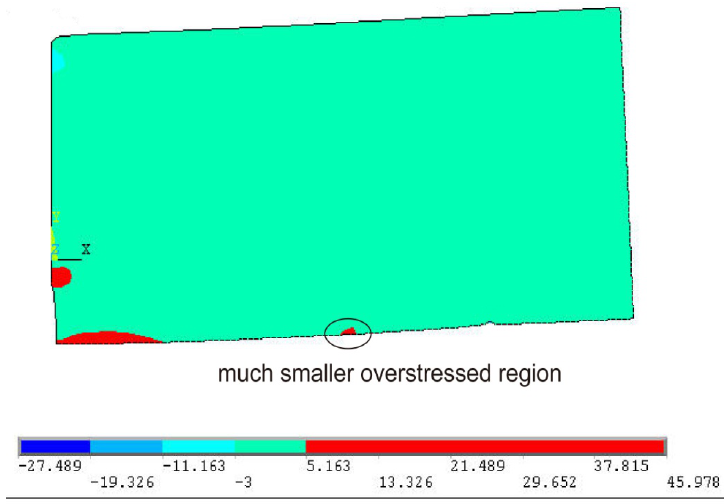
Figure 14. The distribution for the maximum principle stresses in concrete material at the end of CFRP with a length of 0.20